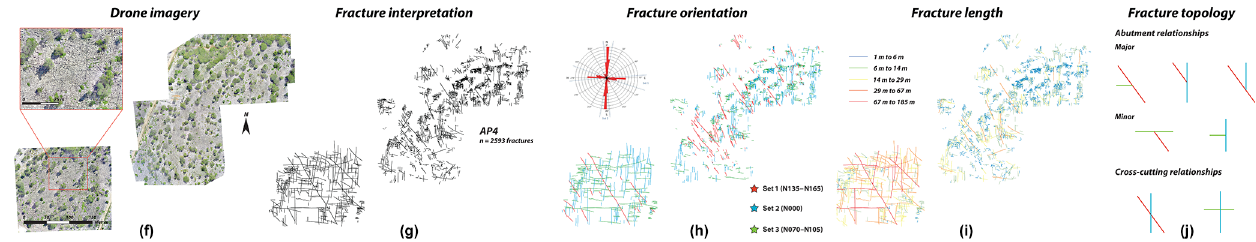
Figure 4. Data acquired in the area of interest from AP4. (a) Orthorectified high-resolution pavement aerial images acquired using a drone; (b) fracture interpretation on orthorectified images; (c) fracture orientation calculated from the north in a GIS-based environment, and the corresponding rose diagram for both outcrops; (d) the length of each fracture trace; and (e) the fracture topology relationship for each pavement observed on fracture network